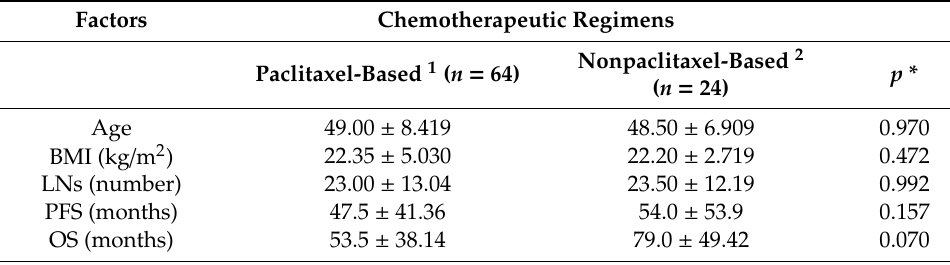
Table 1. Basic characteristics of the study